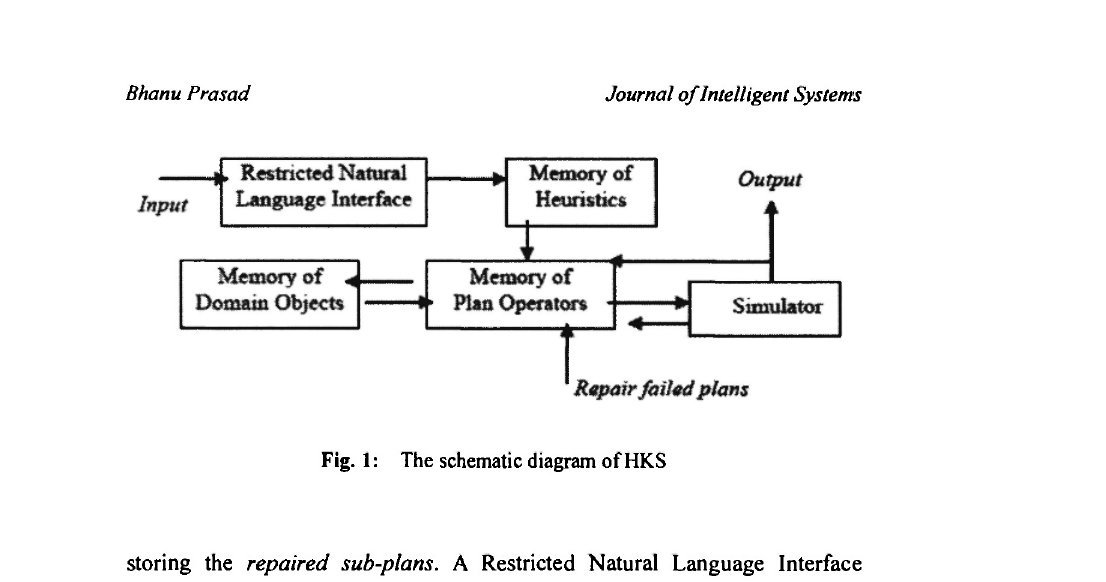
Fig. 1: The schematic diagram of